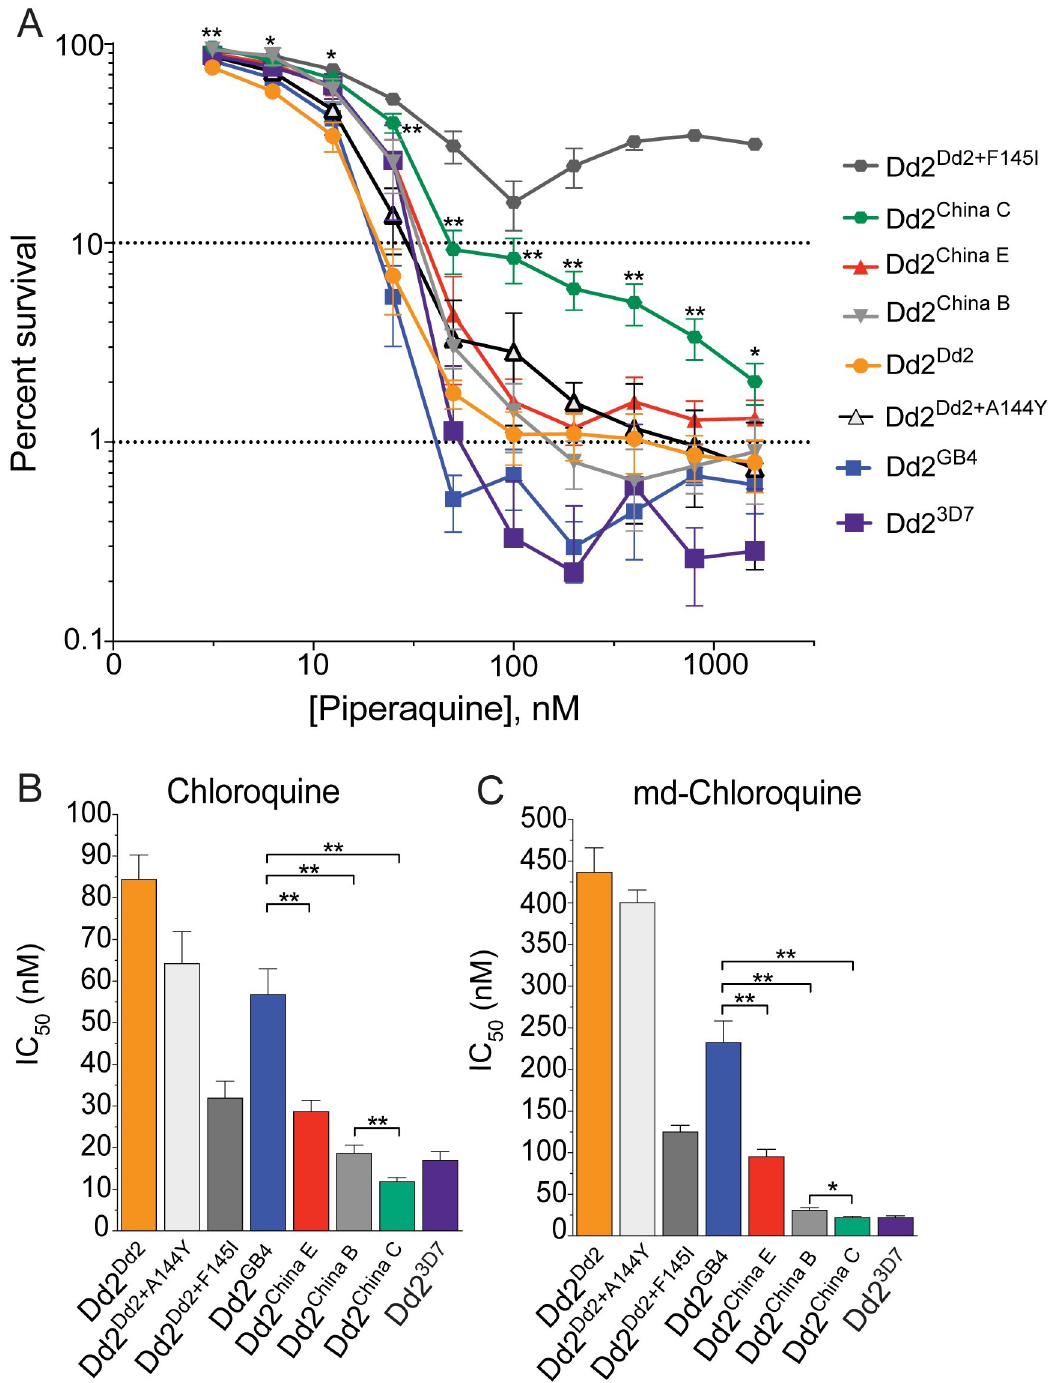
Fig 1. Dd2 China C parasites demonstrate moderate PPQ resistance and re-sensitization to CQ and md-CQ. ( A ) Survival of pfcrt - modified parasite lines cultured with varying concentrations of PPQ (starting with 0–6 hr rings and treated for 48 hr). The 10% cutoff represents a standard 200 nM threshold for PPQ resistance. Survival values are shown as means ± SEM (S1 Table). N , n = 5, 2. ( B, C ) Mean ± SEM IC 50 values (S2 Table) were calculated from 72-hr dose-response assays for ( B ) CQ and ( C ) md-CQ. N , n = 4–7, 2. Statistical significance was determined via two-tailed Mann-Whitney U tests as compared to the isogenic line. � P < 0.05; �� P <